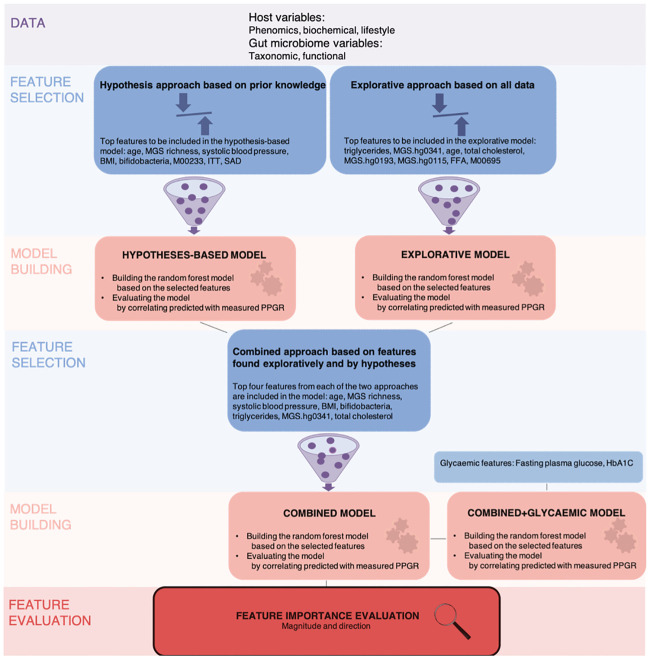
Data overview and experimental design.Host variables including phenomics, biochemical and lifestyle and gut microbiome variables were summarized as functional and species abundance profiles adjusted for bacterial cell counts of faecal samples. Data were randomly split into training (70%) and test (30%) sets. By two approaches, a hypothesis-driven and an explorative approach, features were selected and ranked according to the number of times selected in 200 rounds of top-down searches for important features applying wrapper algorithms build around random forest models predicting postprandial plasma glucose responses. In the hypothesis-based approach the number of features were reduced from 36 features selected from a priori knowledge to eight features, whereas in the explorative approach eight features were selected from all of the data comprising a total of 1368 features. For each approach, a random forest model predicting postprandial plasma glucose responses based on the eight selected features was trained and evaluated on the test set by correlating predicted with measured postprandial plasma glucose excursions. A combined random forest model predicting postprandial plasma glucose responses was trained based on the top features from each feature selection results thereby exploiting both approaches. The combined model was evaluated on the test set by correlating predicted with measured postprandial plasma glucose responses and the importance of the predictor features in terms of magnitudes and directions were evaluated individually and for the microbiome features combined. Finally, glycaemic features were added to the combined model to enable comparisons to previous findings in the literature.